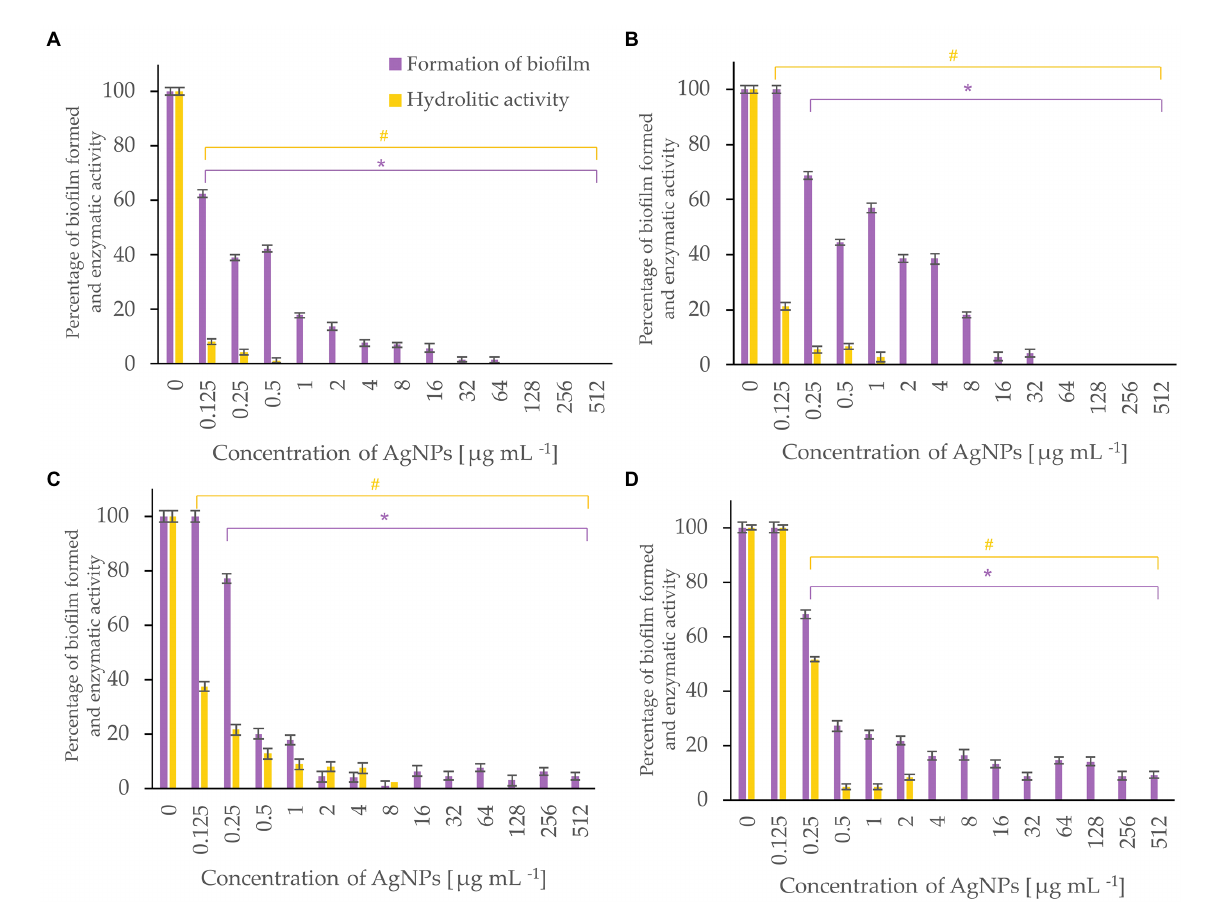
FIGURE 7 Percent of bacterial biofilm formation and hydrolase activity in biofilms after treatment with various concentrations of AgNPs from F. culmorum strain JTW1. A. tumefaciens (A) , P. carotovorum (B) , P. syringae (C) , X. campestris (D) . The statistical significance (value of p < 0.05) of tested variants (different concentrations of AgNPs) compared with untreated control were indicated by * and # signs for biofilm formation and hydrolytic activity tests, respectively.